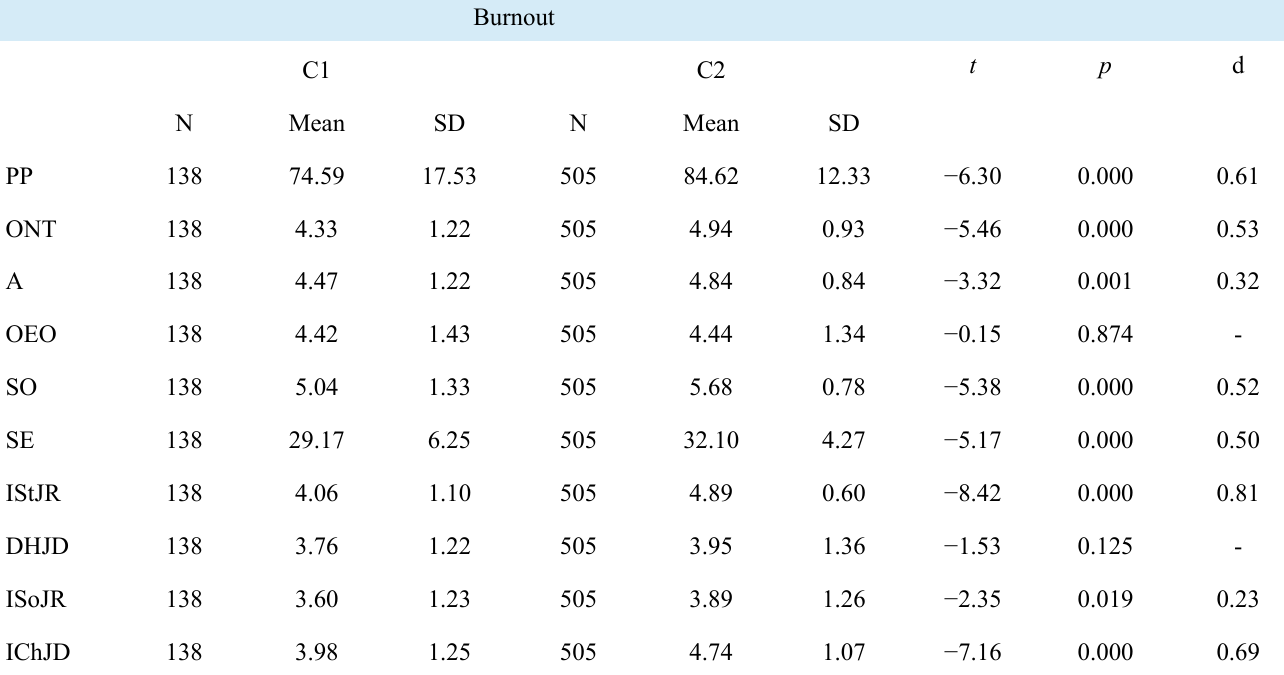
TABLE 2. Proactive personality, regulatory focus, Self-efficacy and Job Crafting. Descriptive statistics and t -test by burnout